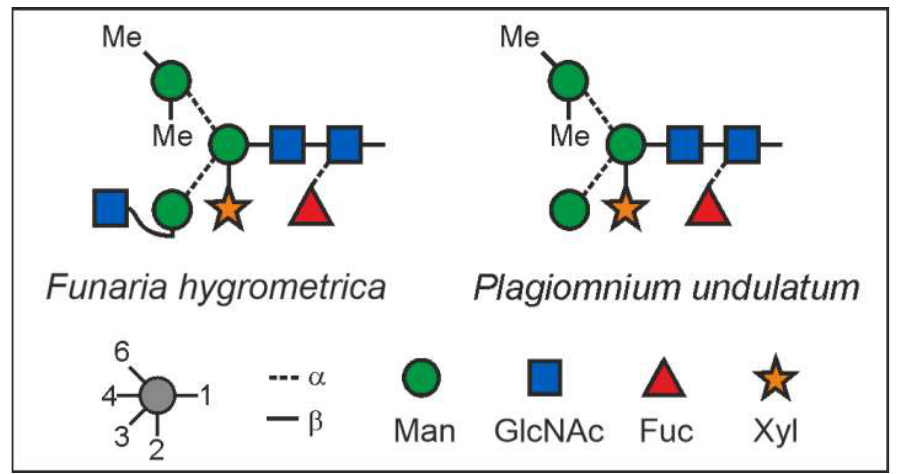
Figure 4. N-glycan structures of the main glycans from Funaria hygrometrica and Plagiomnium undulatum.